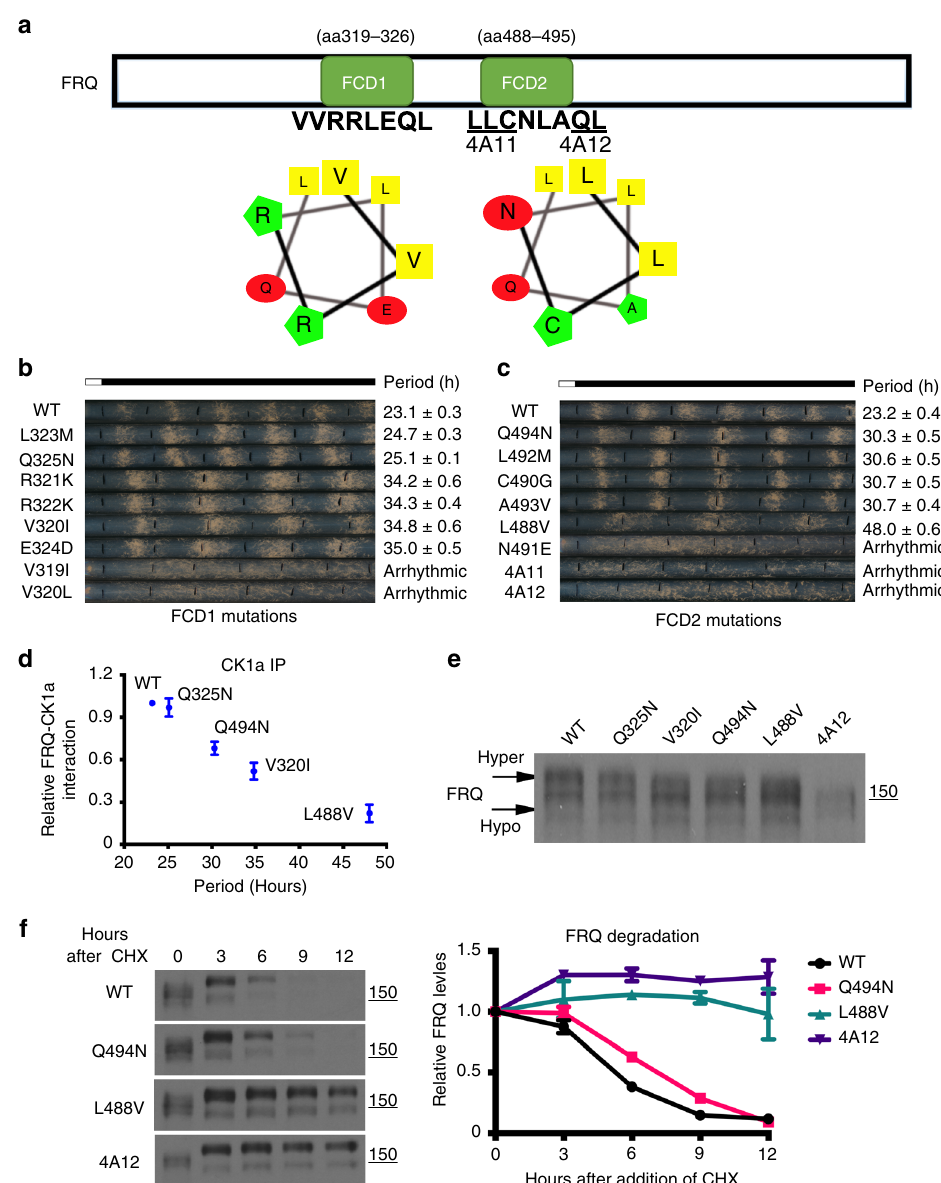
Fig. 2 Dramatic impact on period by mutating the FCD domains. a A schematic diagram showing the FRQ FCD1 and FCD2 domains. The amino acid sequences within the domains that are critical for FRQ-CK1a interaction and helical representations are shown. The 4A11 and 4A12 mutations previously shown to completely disrupt the FRQ-CK1a interaction are indicated 45 . b , c Race tube assays showing the circadian conidiation rhythms and the period lengths of strains with mutation in b the FCD1 and c the FCD2 domains. Errors are standard errors of means ( n = 5). d c-Myc immunoprecipitation assay showing that the amount of FRQ-Myc.CK1a in selected FCD period mutant strains relative to the amount in the wild-type strain. The strains were cultured in LL. Error bars are standard deviations ( n = 4). e Western blot analysis comparing the FRQ phosphorylation pro fi les in the indicated strains. Strains were cultured in LL. Arrows indicates hyper- and hypo-phosphorylated FRQ. The position of the molecular weight marker is indicated. f Western blot analysis of FRQ in indicated strains after CHX treatment. Both hyper- and hypo-phosphorylated forms of FRQ are included in the quanti fi cation. The densitometric analysis is shown on the right. Error bars are standard deviations ( n = 3). Source data are provided as a Source Data fi